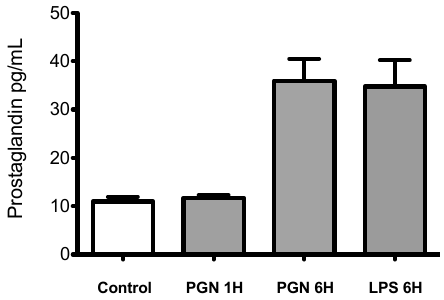
Figure 6. Characterisation of the prostaglandin (PGE 2 ) response. PGE 2 levels in primary cell cultures stimulated for 1 and 6 h with PGN and 6 h with LPS (10 μ g/mL) from Escherichia coli O111:B4. Results (mean ± SD; n = 6) from six independent experiments are expressed as pg of PGE 2 /mL.